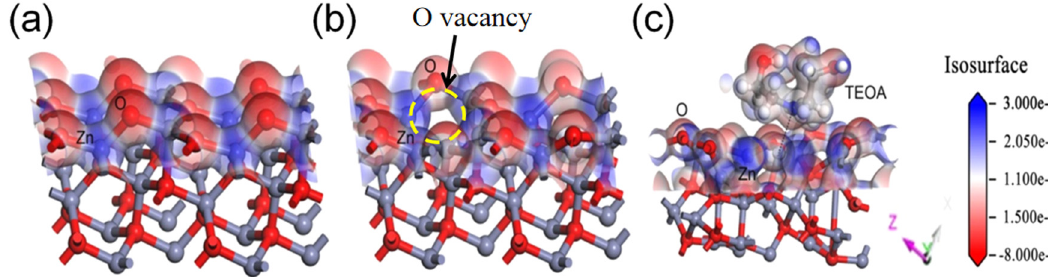
Figure 7: Schematic diagram of the ( a ) ( 101 ) plane of the initial ZnO, ( b ) ( 101 ) plane of ZnO with a single oxygen vacancy, and ( c ) ( 101 ) plane of ZnO with a single oxygen vacancy coupled with a TEOA